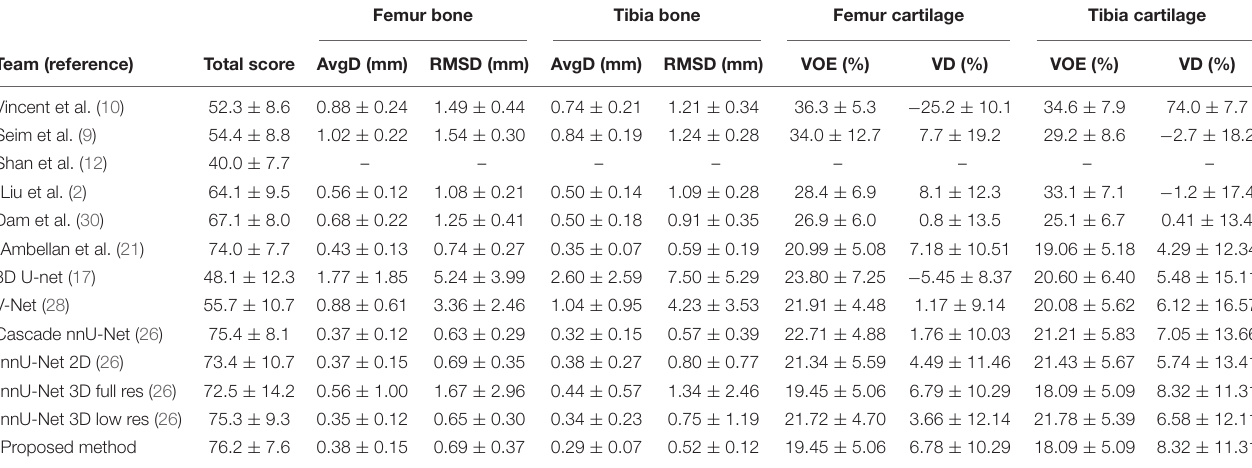
TABLE 1 | Comparison of automatic segmentation methods based on the Segmentation of Knee Images 2010 (SKI10) validation data. Femur bone Tibia bone Femur cartilage Tibia